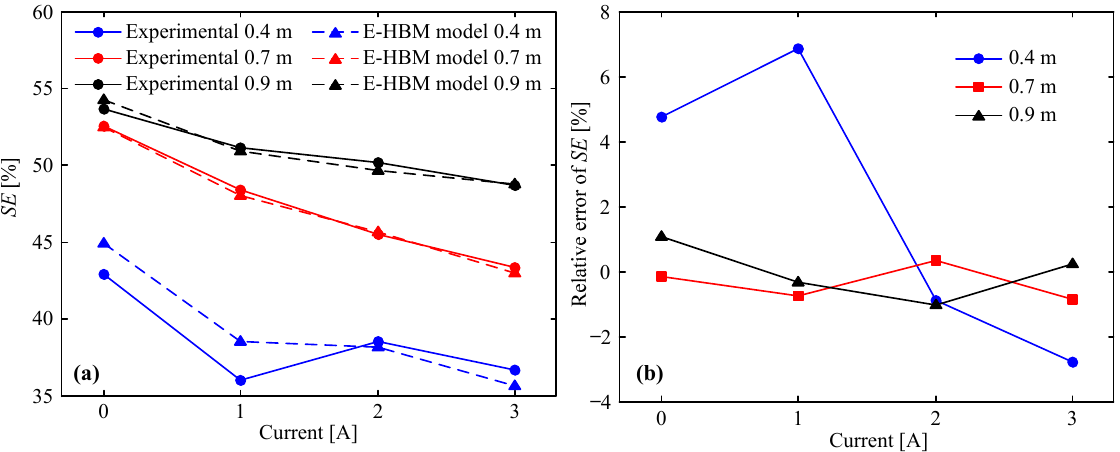
Figure 12. E–HBM model vs. measured data at different drop heights: ( a ) SE , ( b ) relative error of SE .